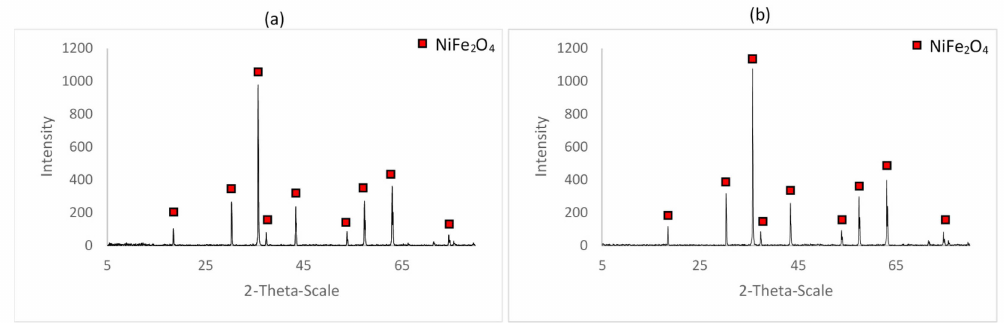
Figure 7. XRD spectra for samples ( a ) A_4 (72 h at 1000 ◦ C) and ( b ) A_5 (96 h at 1000 ◦